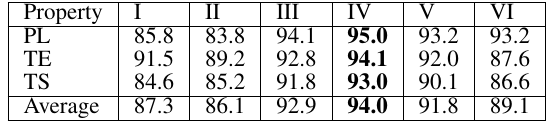
Table 2. Overall accuracies [%] of the six experiments for the properties production place (PL), production technique (TE) and production timespan (TS) and average